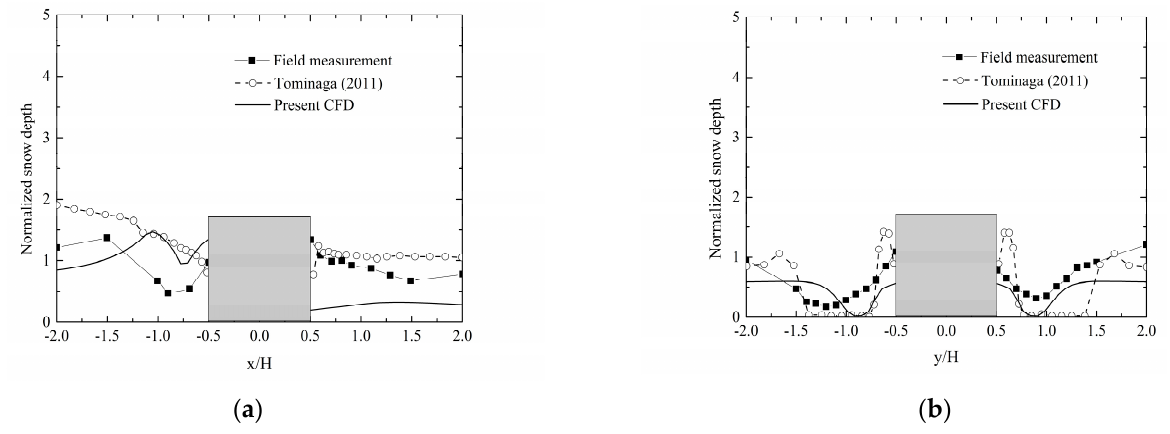
Figure 9. Normalized snow depth of the numerical simulation. Figure 10. Comparison of numerical simulations and field measurement: ( a ) streamwise direction; ( b ) lateral direction.